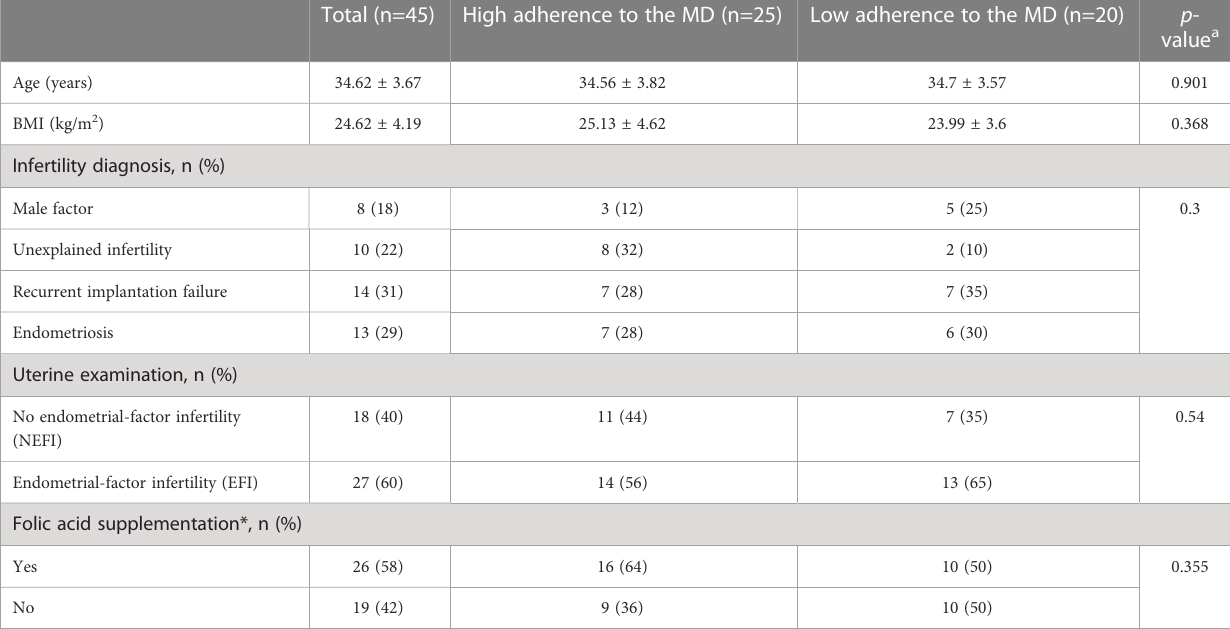
TABLE 1 Patient ’ s demographics based on the adherence to Mediterranean Diet